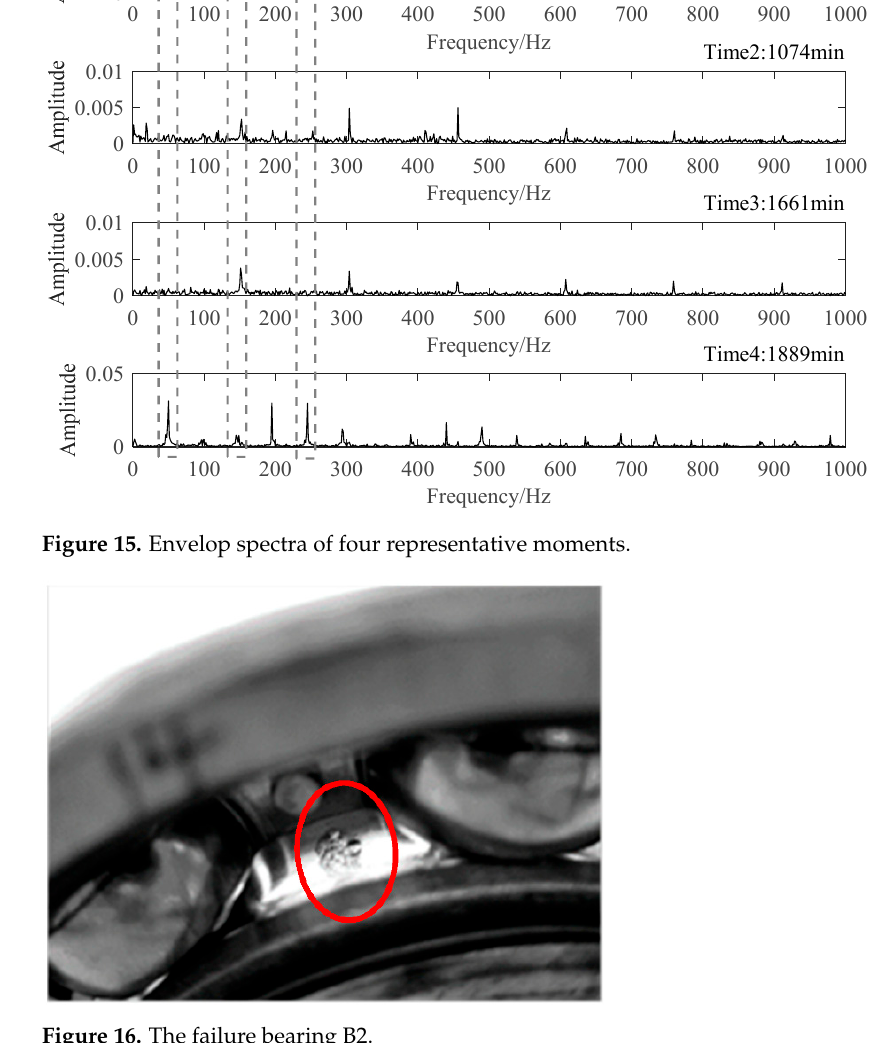
Figure 16. The failure bearing B2.